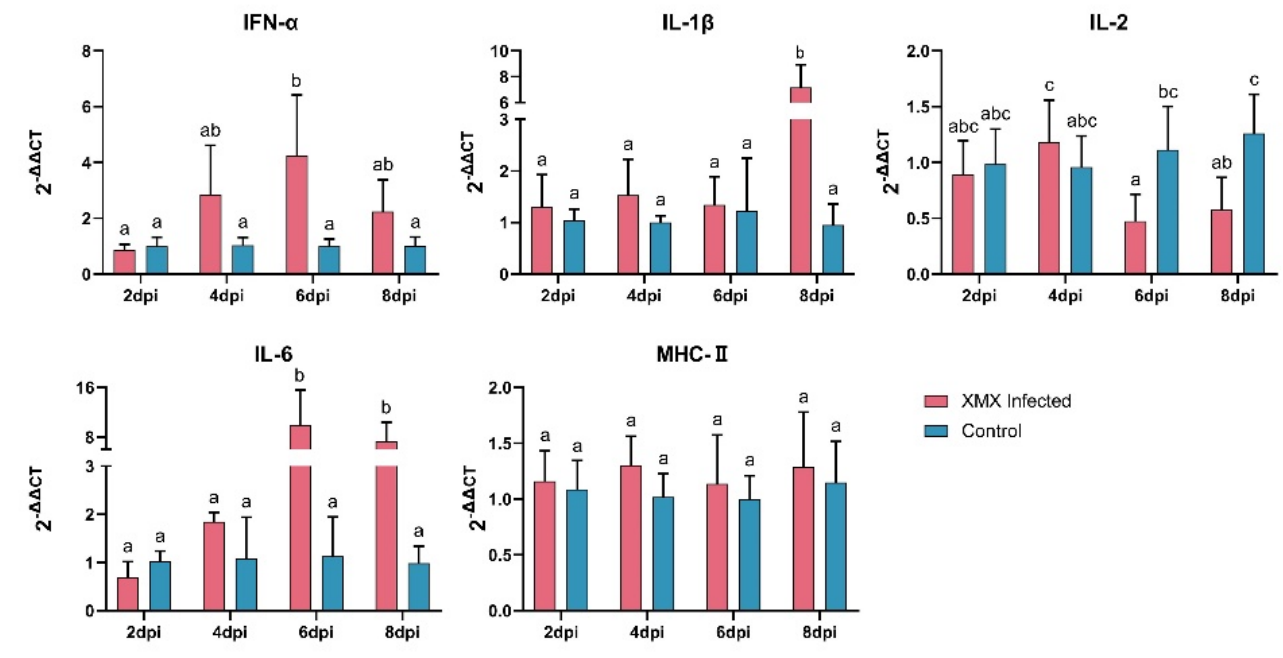
Figure 2. The mRNA expression of IFN- α , IL-1 β , IL-2 , IL-6 , and MHC-II in the ileum after XMX infection, as found by qRT-PCR. Different letters indicate significant differences.